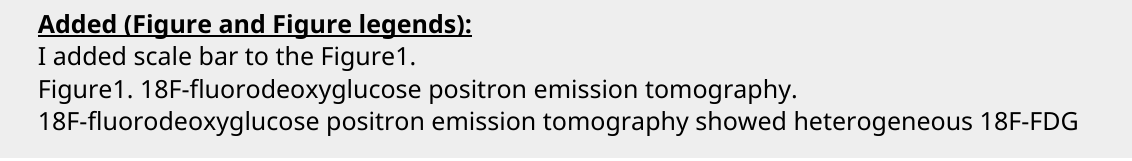
Figure1. 18F-fluorodeoxyglucose positron emission tomography. 18F-fluorodeoxyglucose positron emission tomography showed heterogeneous